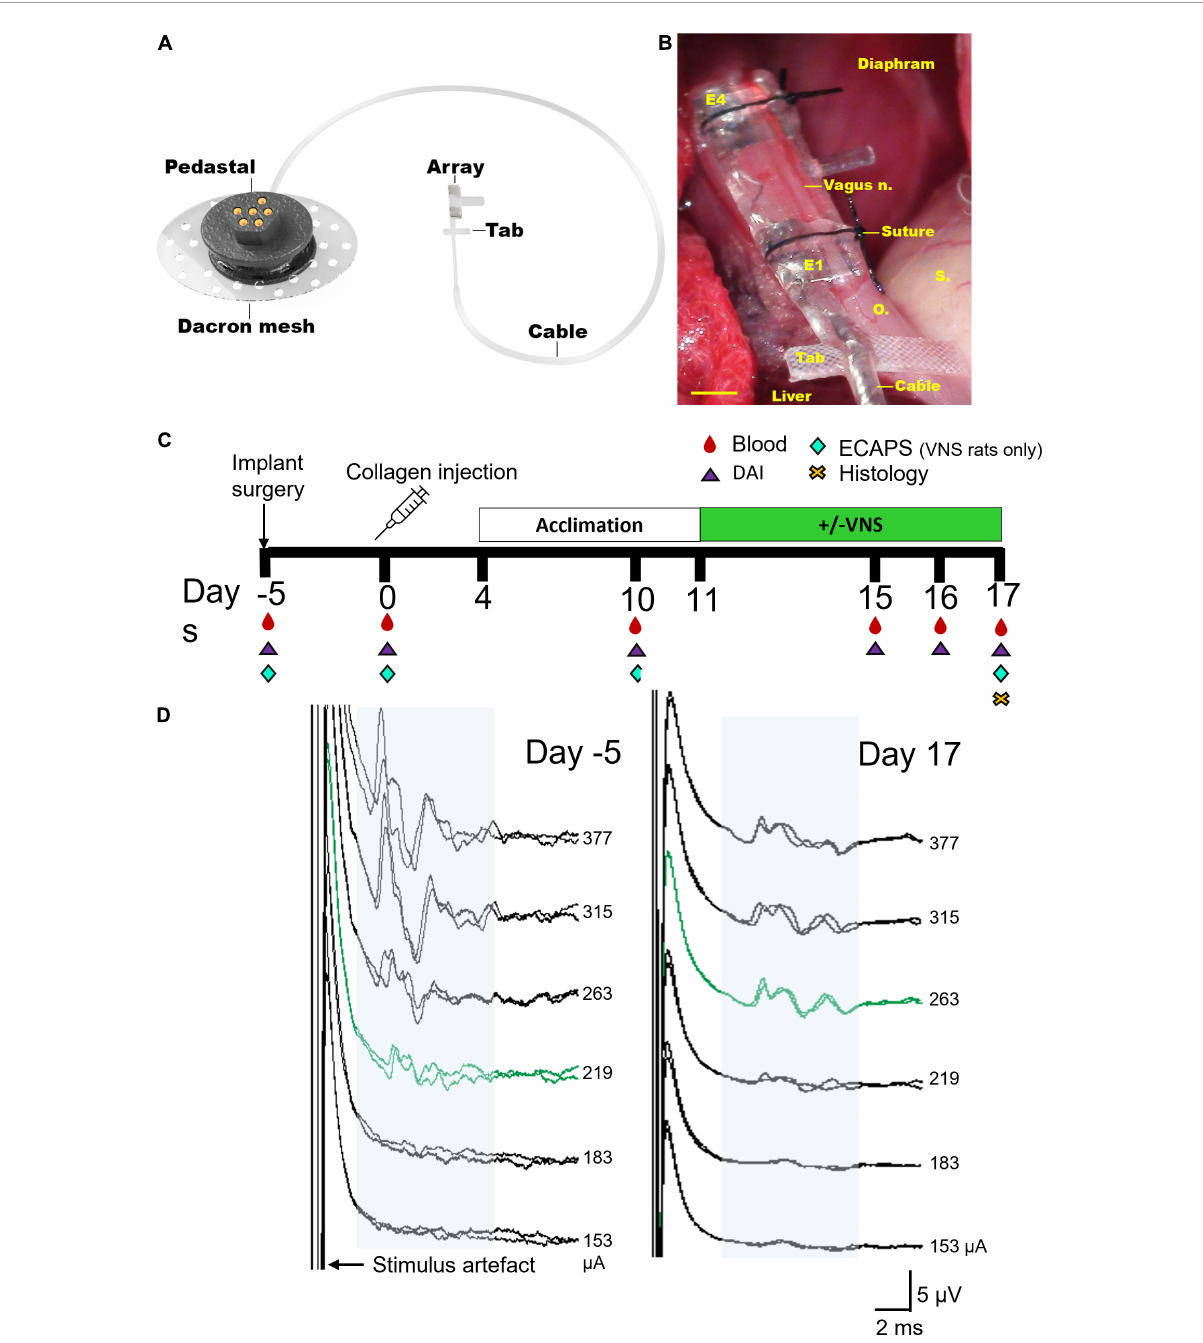
FIGURE1 Electrode array and experimental schedule. (A) Rendered drawing of the cuff electrode array and percutaneous pedestal. (B) An in vivo image shows the placement of the array below the diaphragm on the ventral esophagus (“o”) adjacent to the stomach (“s”) and liver. The sub-diaphragmatic anterior abdominal vagus nerve (vagus n.) was implanted and sutures used to hold the lid of the device closed. The tab was sutured to the underlying esophagus (“o”) for stability. Electrodes 1 and 2 (E1–E2) were used to deliver bipolar stimulation while electrodes 3 and 4 (E3–E4) recorded electrically evoked compound action potentials. (C) Experimental schedule for the chronic stimulation experiment (DAI: disease activity index, includes assessments on locomotor function, macroscopic digit inflammation and ankle swelling; ECAPs: electrically evoked compound action potentials). Collagen-induced arthritis was observed in rats on days 15–17. (D) Representative electrically evoked compound action potentials (ECAPs) after surgery (day -5) and before termination (day 17). Neural thresholds are indicated in green (day -5: 219 µ A; day 17: 263 µ A) and the neural response window in light blue shading. Current amplitude (in µ A) is indicated to the right of each set of ECAPs. Scale bar in panel (B) represents 1